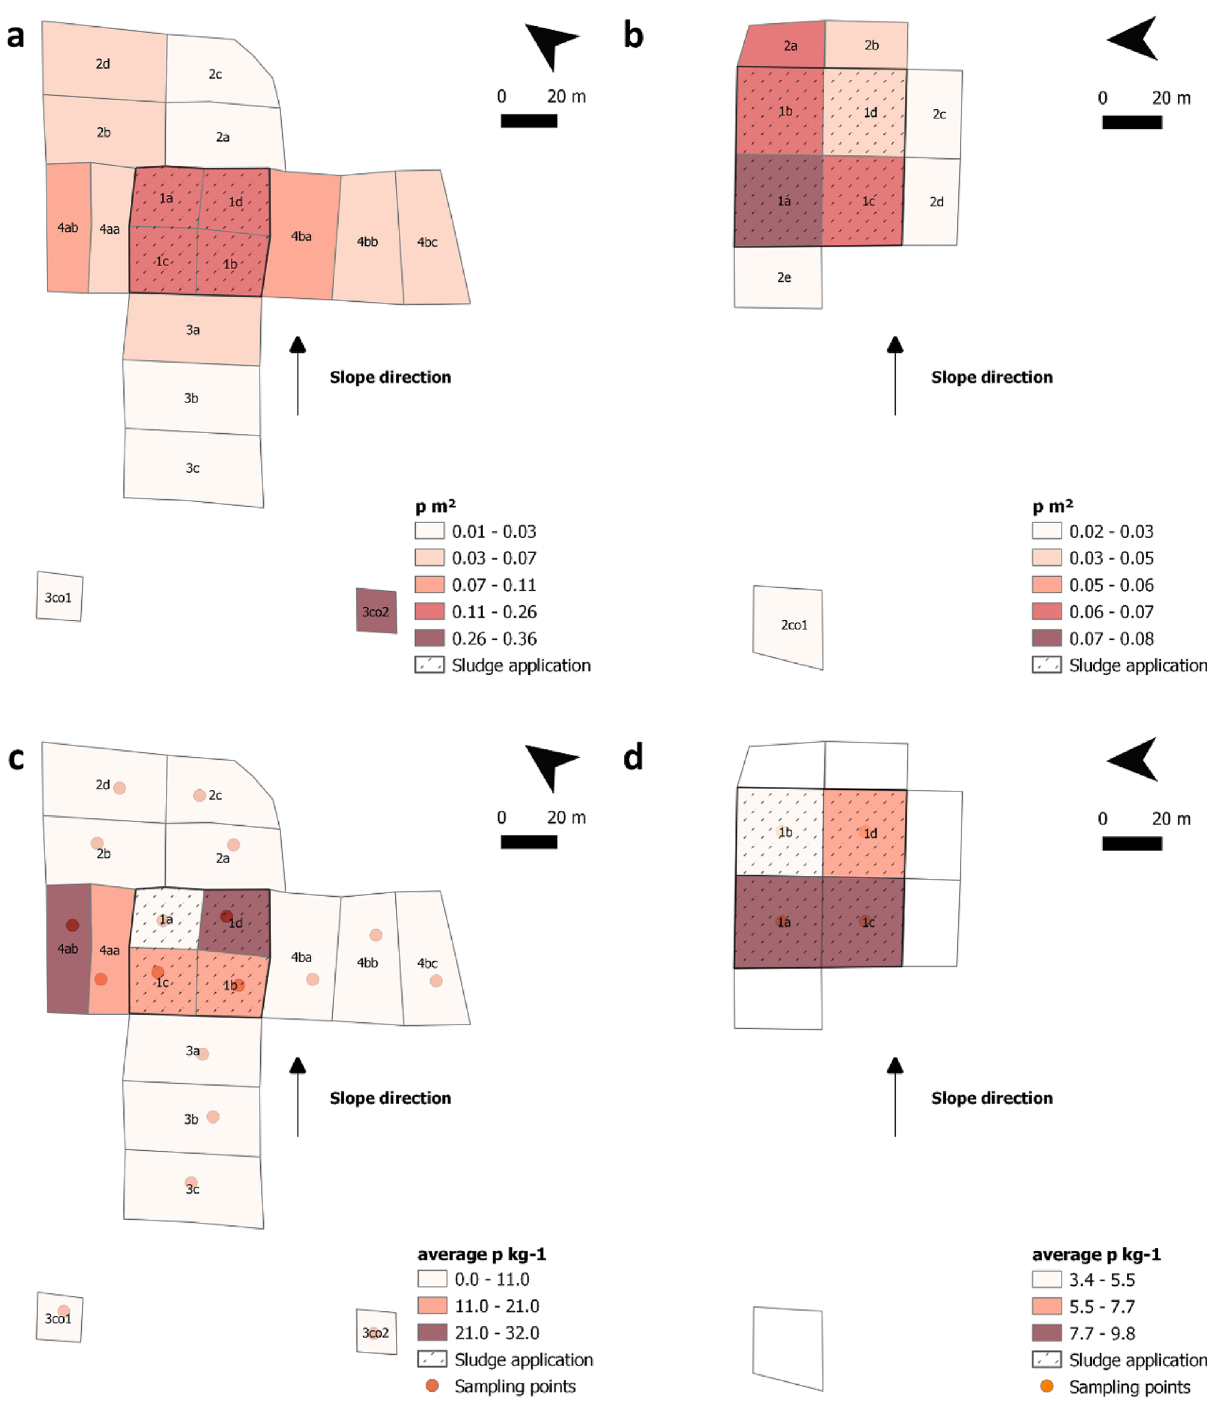
Figure 1. Surface plastic concentration (p m 2 ) on agricultural field ( a ) “Lehmkaute” (LK) or ( b ) “Holzbach” (HB) and average microplastic concentration (p kg -1 ) over entire soil column in agricultural field ( c ) “Lehmkaute” and ( d ) “Holzbach” (Overview of sampling sectors and points based on a digital terrain model provided in Supplementary Fig. terephthalate (PET). The aforementioned common polymers accounted for 74.8% of the composition on plastic at field LK, and 79.9% at field HB. The share of polymer composition, especially within other polymers, including polyvinyl chloride (PVC), polysulfone (PES), polycaprolactam (nylon 6) or synthetic resins, showed substantial variation among the different sector groups (Fig. 3c).